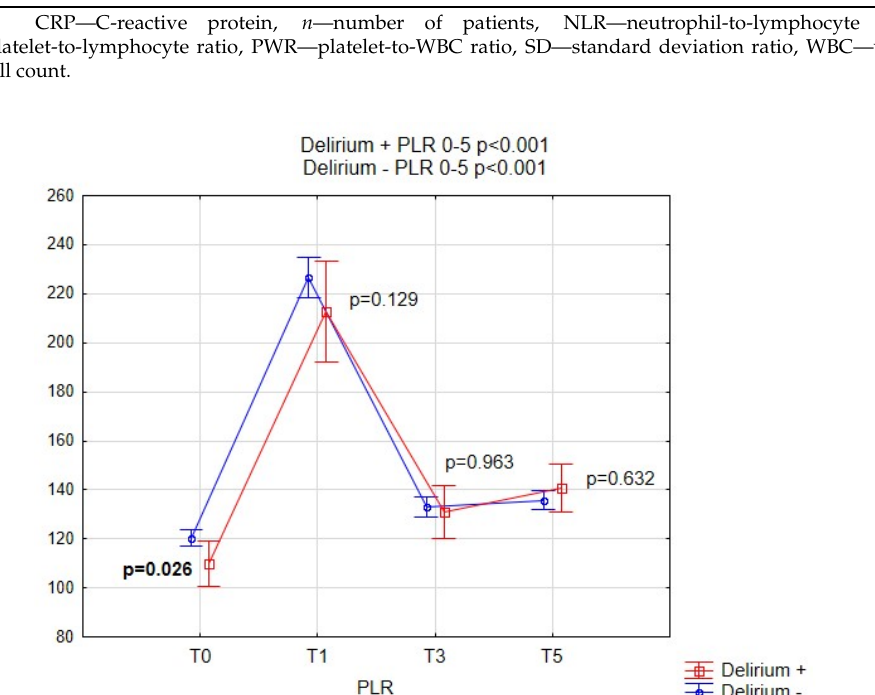
Figure 4. Pre-operative and post-operative PWR values for patients with and without POD. PWR, platelet-to-WBC ratio; POD, Postoperative delirium.